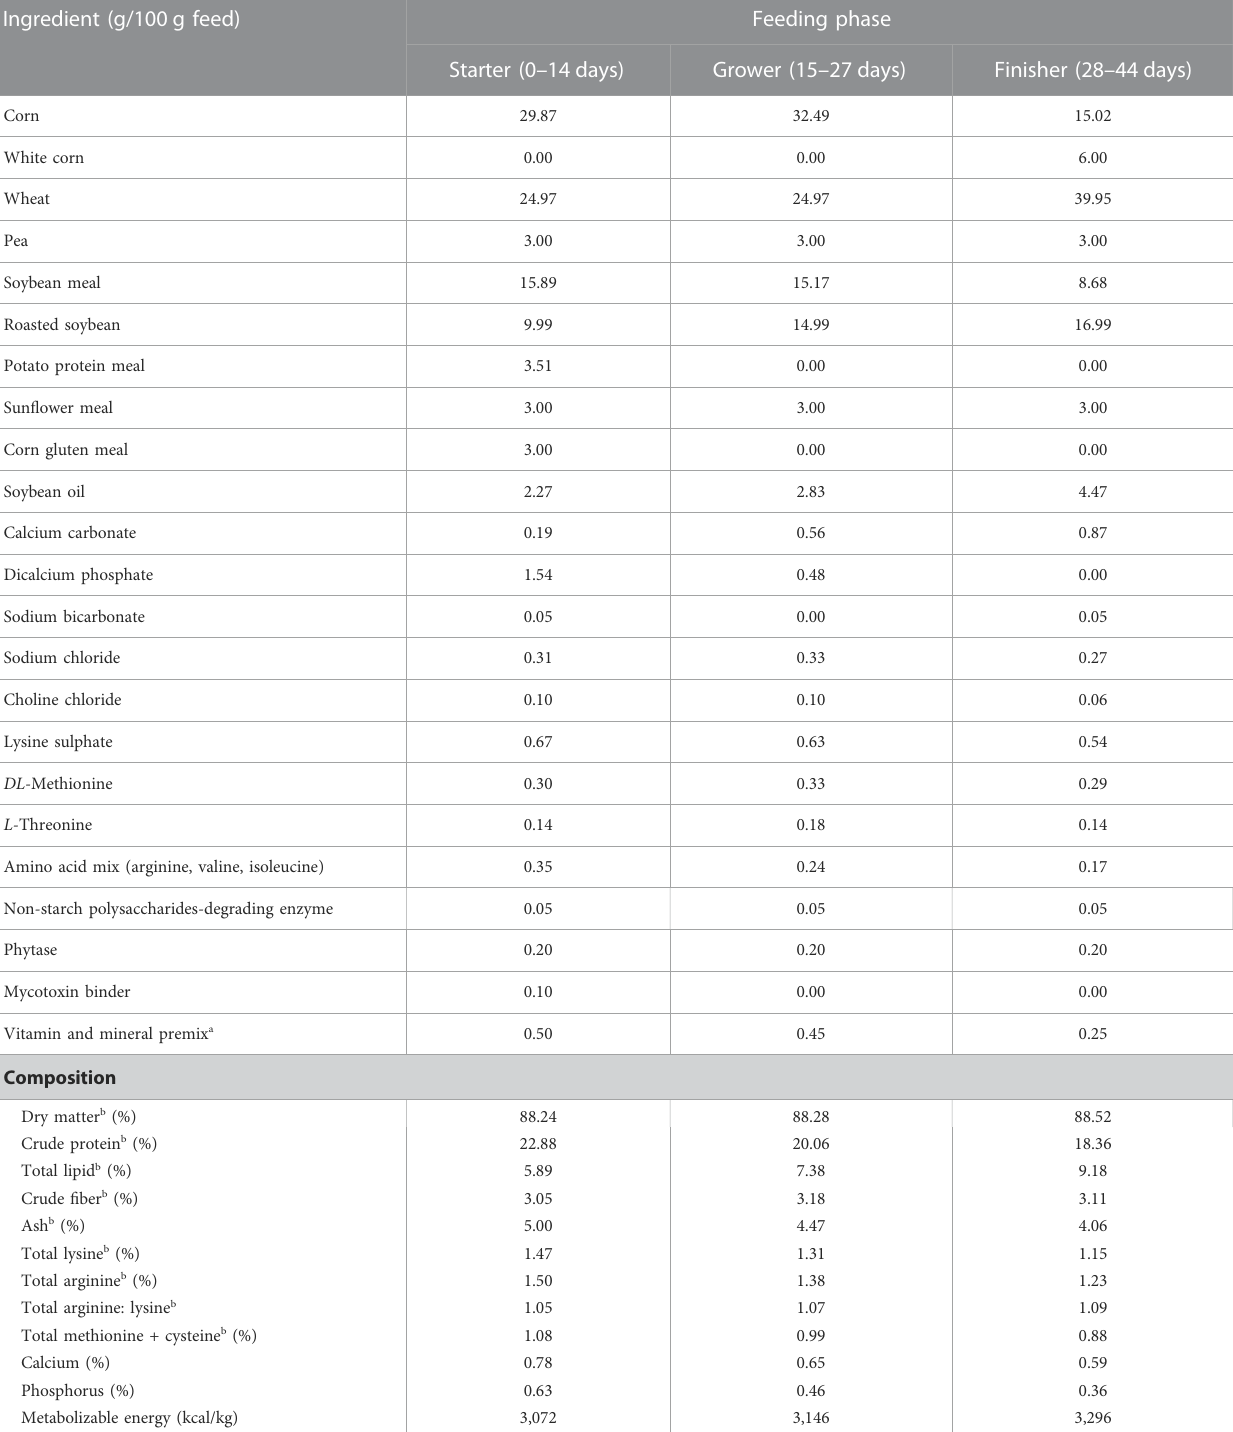
TABLE 1 Basal diet formula and composition according to the 3-phase feeding program. Ingredient (g/100 g feed) Feeding